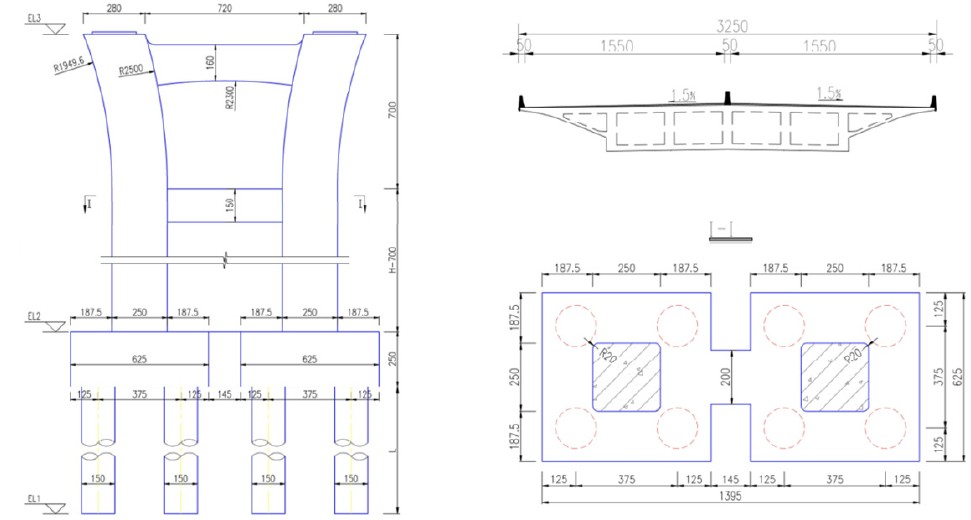
Figure 18. Dimensions of bridge piers, caps and main beams (unit: mm).